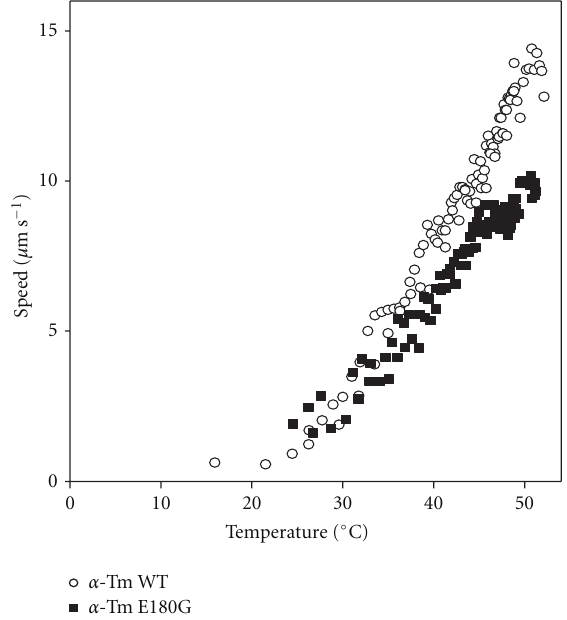
Figure 5: Temperature dependence of sliding speed at pCa 5 for regulated thin filaments reconstituted with HcTn and either α -GS- Tm E180G ( (cid:4) ) or α -GS-Tm WT ( (cid:7) ) [note that the control WT data are a subset of regulated thin filament data replotted from [42]]. Data were obtained during the heating phase of two cycles of heating and cooling in flow cells configured with a microfabricated thermo-electric heater for continuous variation of temperature (see Section 2). Points represent mean of the sliding speed for 3–8 filaments during one second. Note the deviation of mutant Tm data from WT as temperature